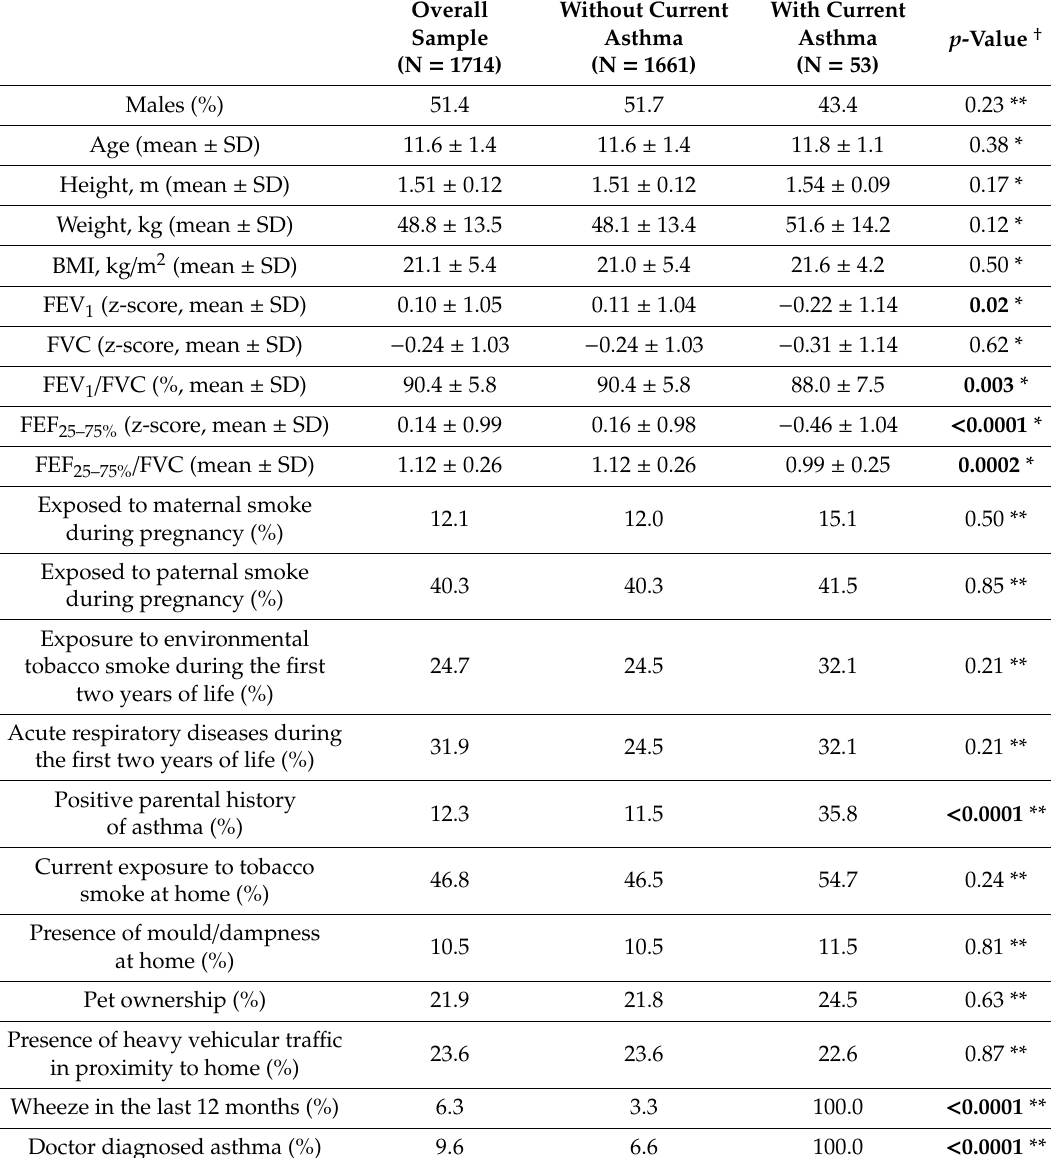
Table 1. Characteristics of study population. Significant p -Values are in bold. Overall Sample (N =